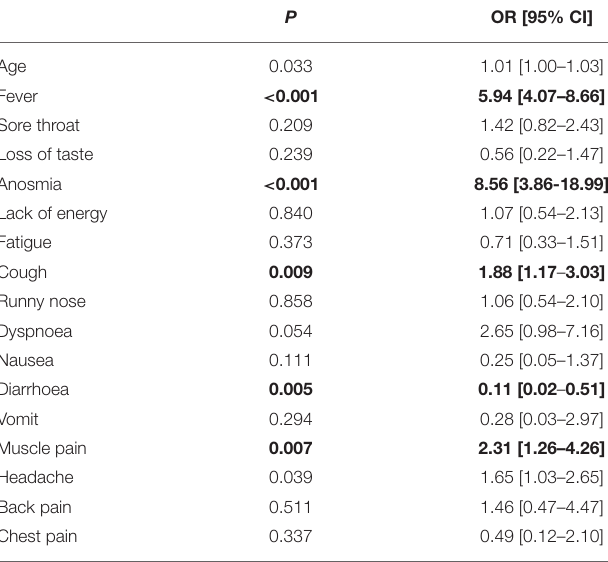
TABLE 2 | Reported symptoms in subjects with positive antigen test results, logistic